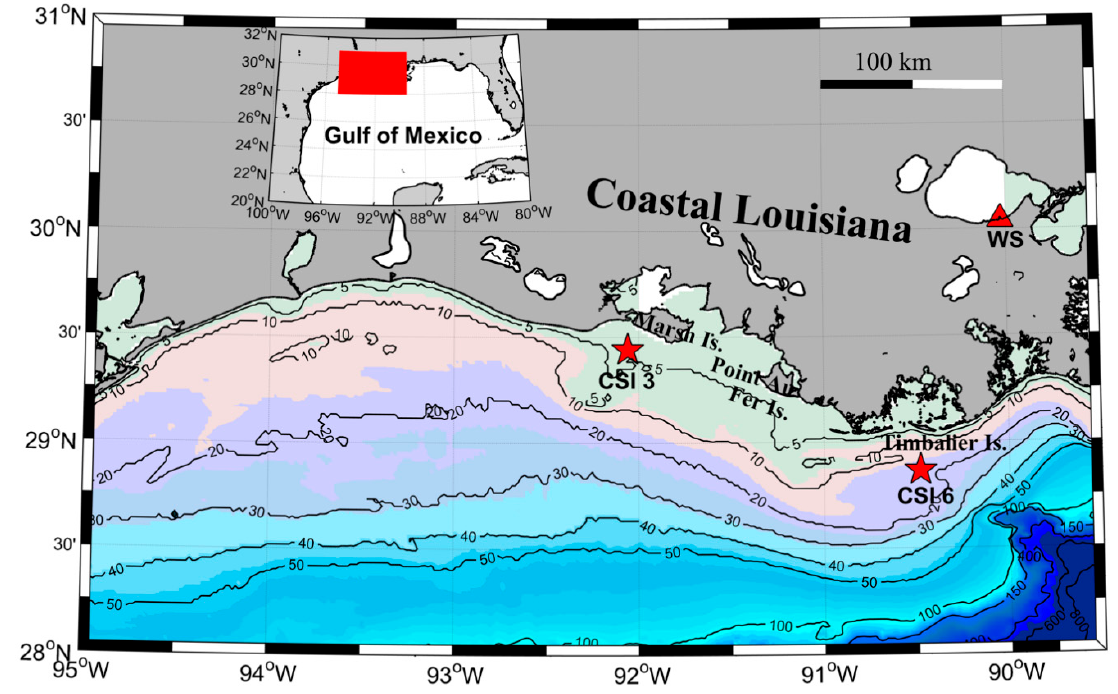
Figure 1. Study area. Contour is the bathymetry (unit: m) from ETOPO1. The red five-pointed stars represent the WAVCIS (http://www.wavcis.lsu.edu/) stations. CSI 3 is off the Marsh Island and the CSI 6 is south of Timbalier Island. The red triangle represents the weather station (WS). The inset shows the study area in southern Louisiana.